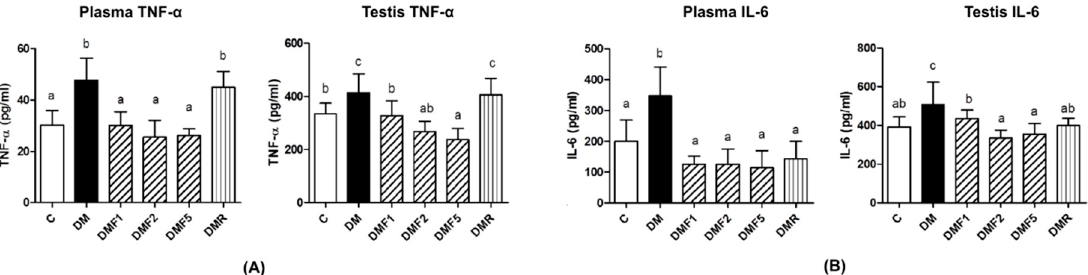
Figure 5. Effects of fucoxanthin on proinflammatory cytokines after treatment for four weeks. ( A ) Tumor necrosis factor (TNF)- α level in plasma and testis, and ( B ) Interleukin (IL)-6 level in plasma and testis. Data are shown as the mean ± S.D. ( n = 5). The values with different letters (a–c) represent significant differences ( p < 0.05) as analyzed by Duncan’s multiple range test. C, control; DM, diabetes; DMF, diabetes treated with fucoxanthin; DMR, diabetes treated with rosiglitazone.